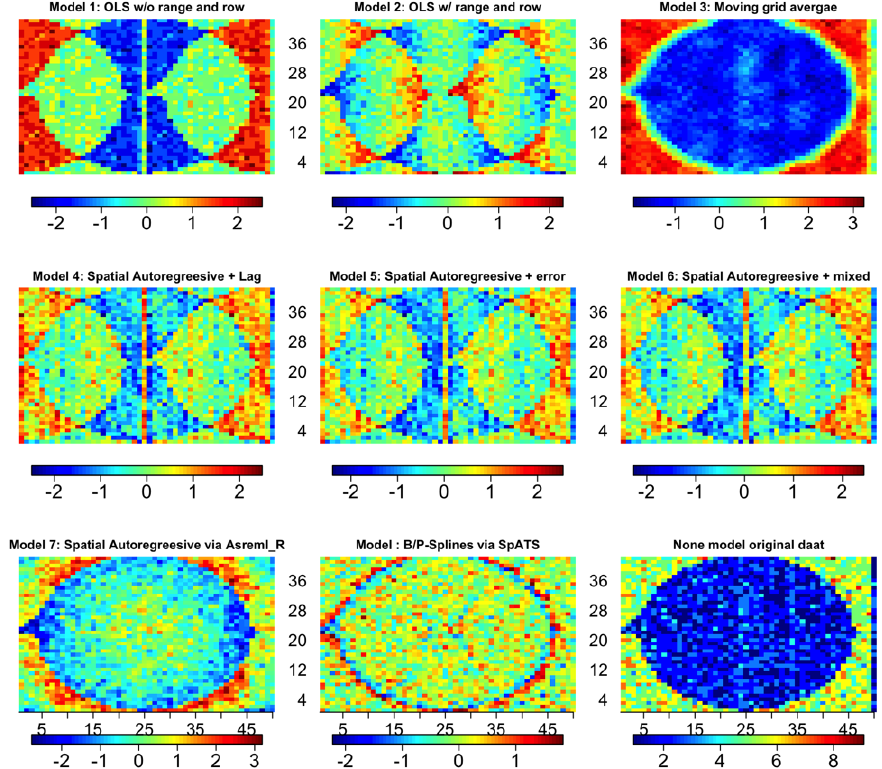
Figure 7. Heatmaps of residuals from data set 1 from the eight models. The eight models, from left to right and up to bottom: OLS w/o RR, OLS w/RR, MovingGrid, SAR + lag, SAR + error, SAR + mixed, ASReml AR1, B/P-Spline. In each figure, the x -axis is the rows from 1 to 50 and the y -axis is the ranges 1 to 42. The numbers under legend bars are the range of residual values, and the numbers above the legend bar in the bottom half of the figure are the row